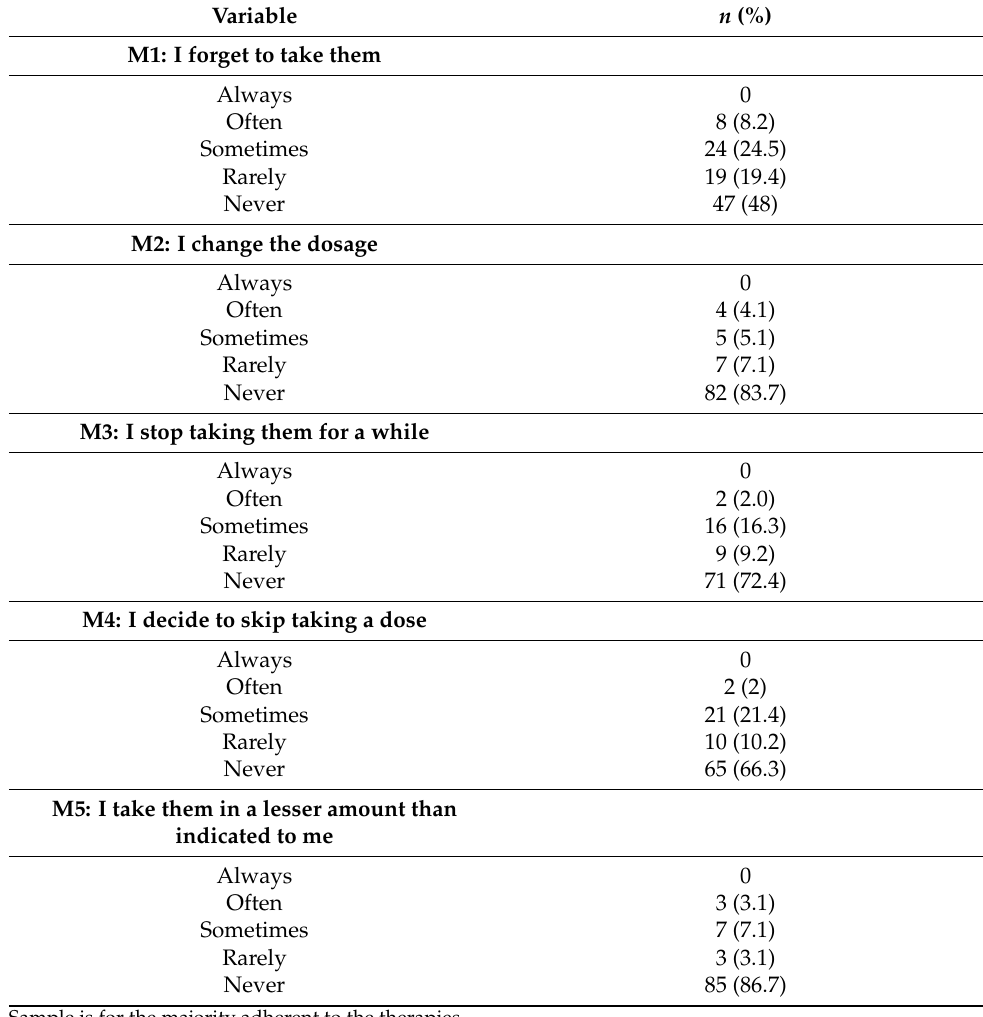
Table 3. Characteristics of responders on reported adherence.